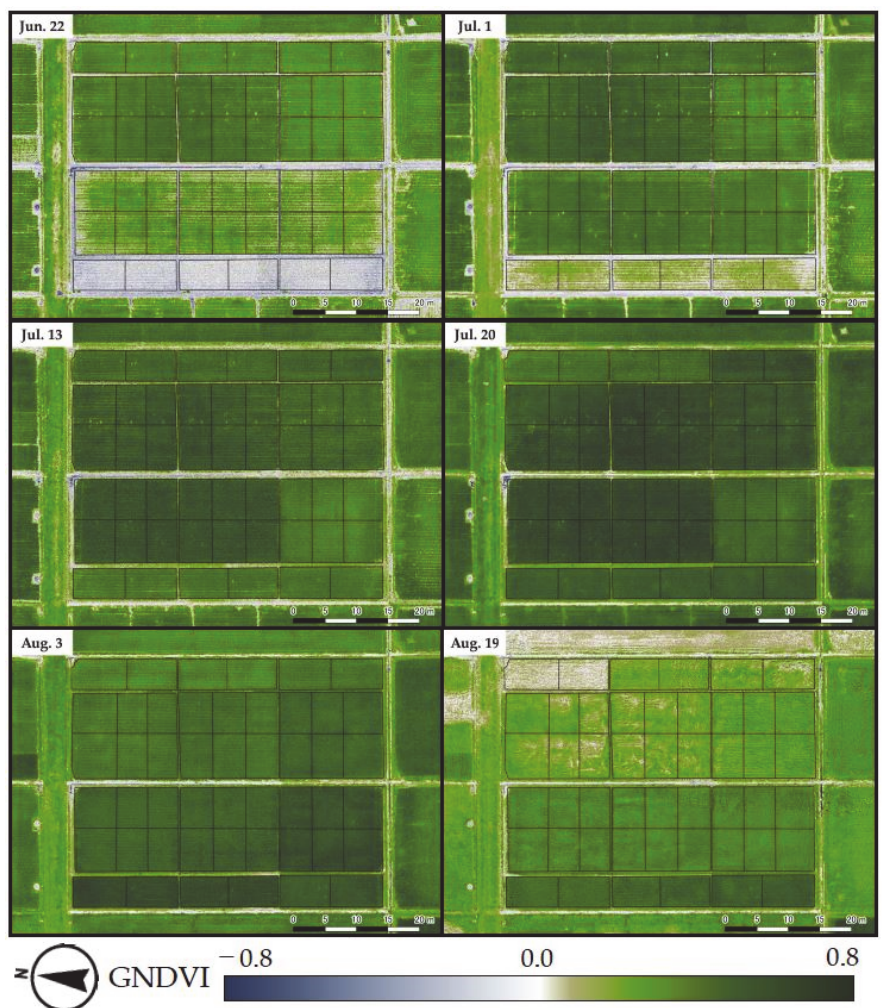
Figure 7. Spatial and temporal variability in green normalized difference vegetation index (GNDVI) from unmanned aerial vehicle imagery in 2016. Black line is the boundary of